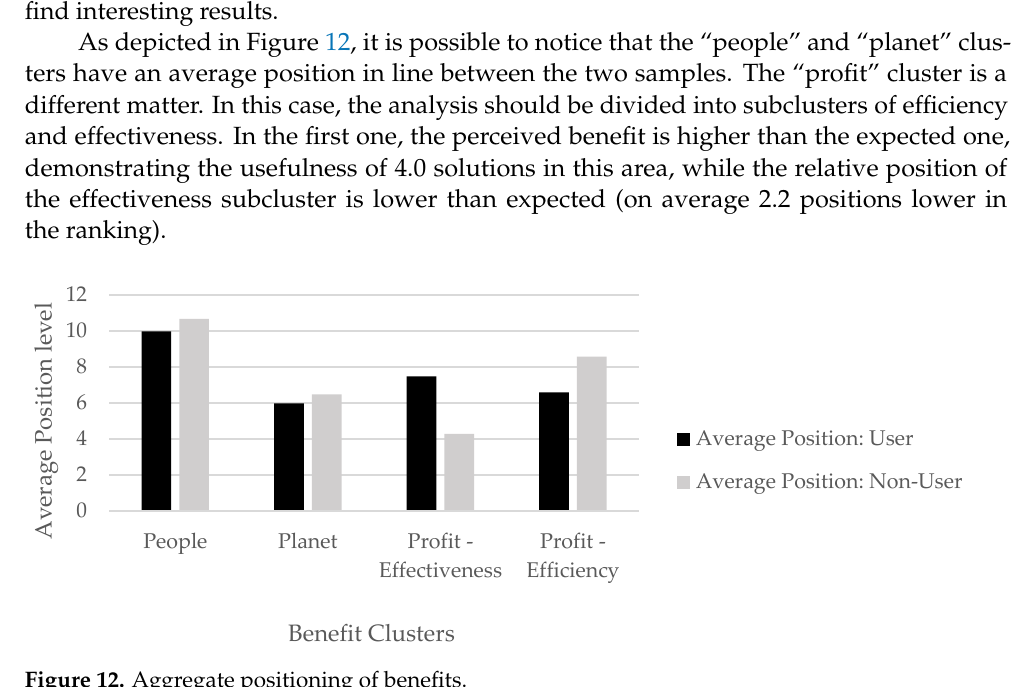
Figure 12. Aggregate positioning of benefits.